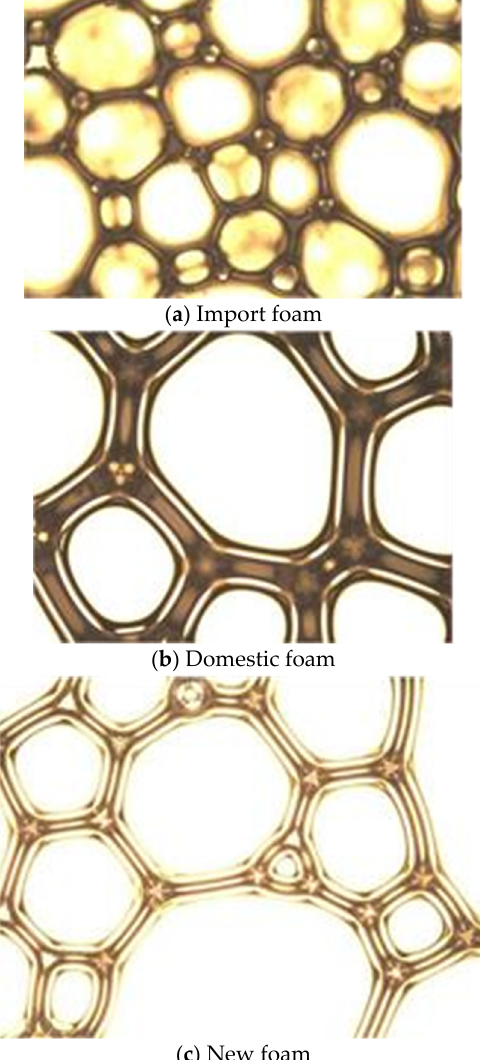
Figure 9. Particle distribution map of different foam images.